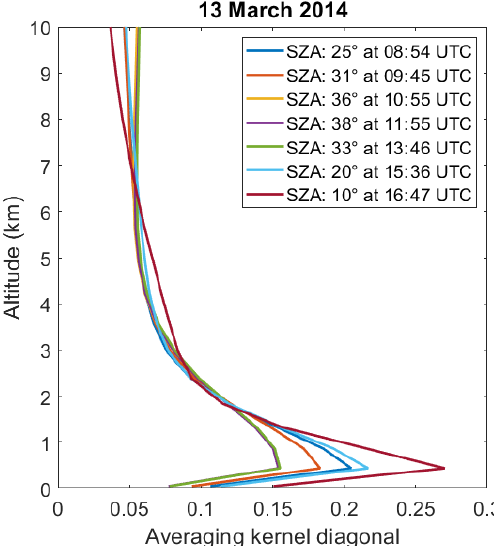
Figure 10. Typical NH 3 –OASIS averaging kernel diagonal ele- ments illustrated on the 13 March 2014 at different times of the day, and solar zenith angles (SZAs in degrees) using spectroscopic data from the HITRAN 2008 (HIT08) database (except for CO 2